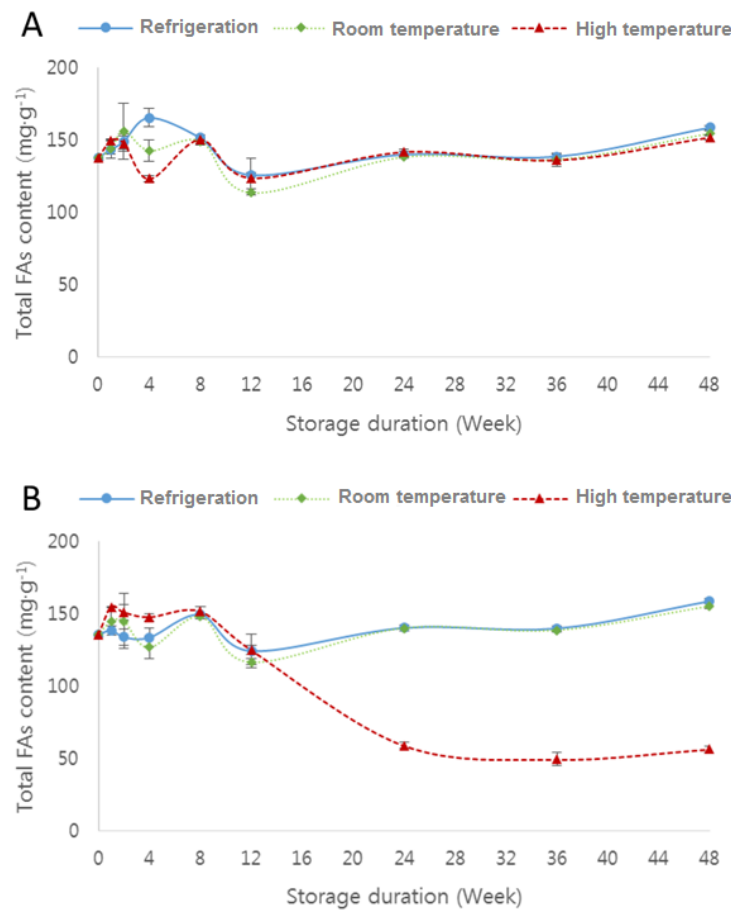
Figure 1. Changes in total fatty-acid (FA) content of raw soybean flour ( A ) and roasted soybean flour ( B ) packed in polyethylene film under different storage temperature conditions: refrigeration (4 °C), room temperature (20 °C), and high temperature (45 °C).